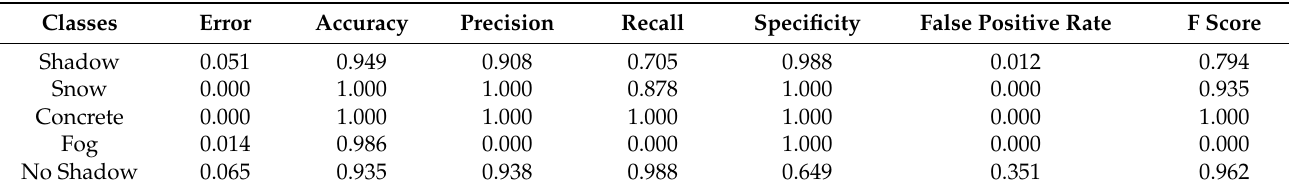
Table 2. AgroShadow classification metrics for shadow / no shadow , fog , snow and concrete